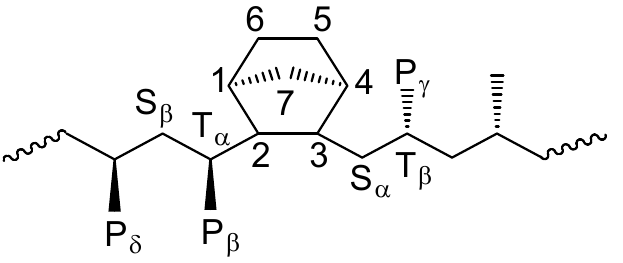
Scheme 7. Schematic representation of a regular P- co -N copolymer chain along with the used numbering of carbons.